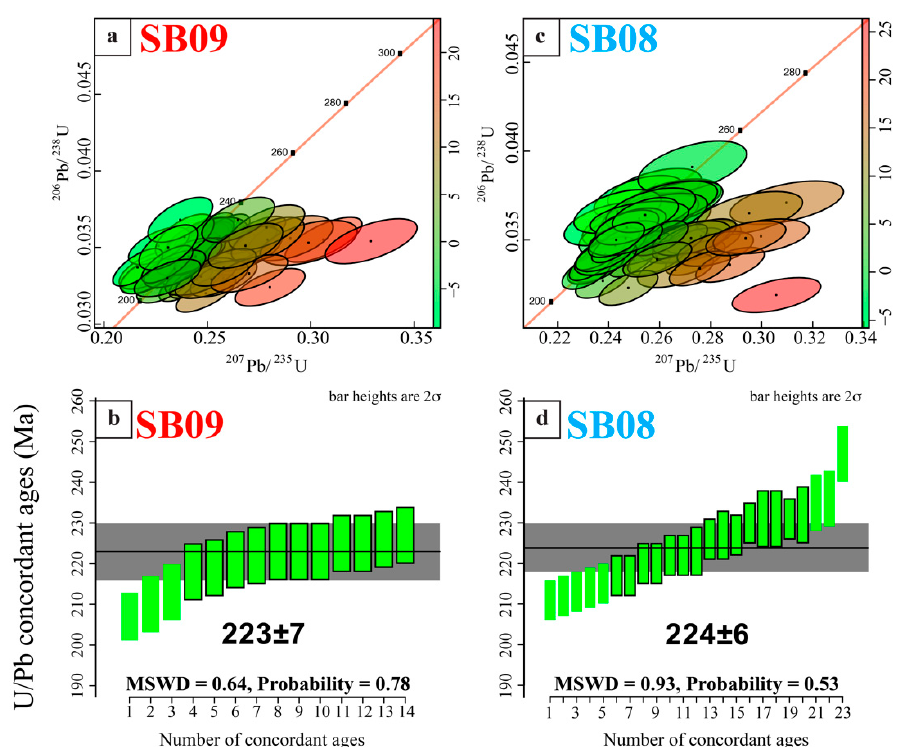
Figure 8. ( a ) and ( c ) U–Pb Concordia diagrams for SB09 and SB08, respectively. ( b ) and ( d ) diagrams of U–Pb concordant data for SB09 and SB08, respectively. The weighted average age reported on each diagram was obtained from data shown as green bars with black contours. Concordia diagrams and weighted mean plots have been performed using the IsoplotR toolbox [66].